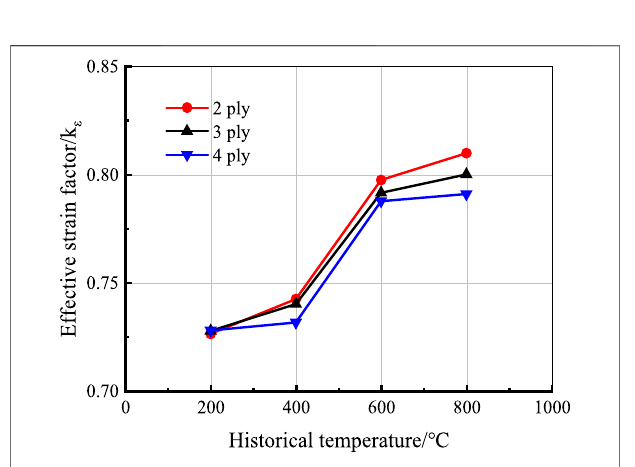
FIGURE 8 | BFRP ef fi ciency factor versus con fi nement